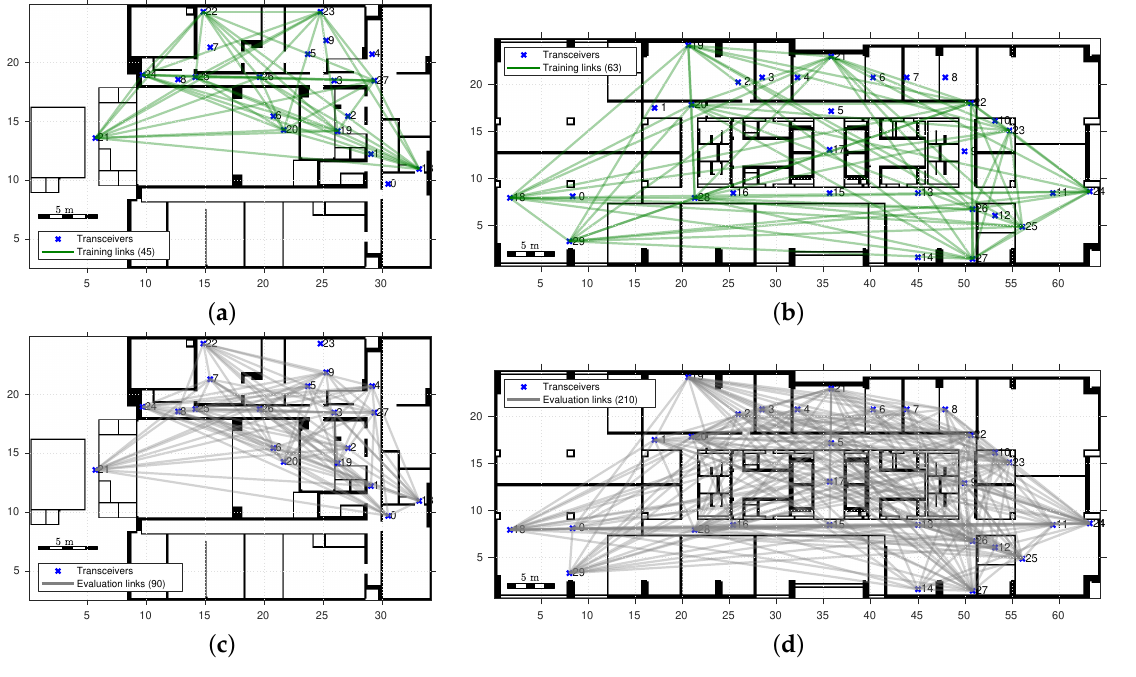
Figure A2. The training links for the ship environment and office environment is shown in ( a , b ) respectively. Floor map of the measurement environments and wireless sensor network deployment. The evaluation links for the ship environment and office environment is shown in ( c , d )